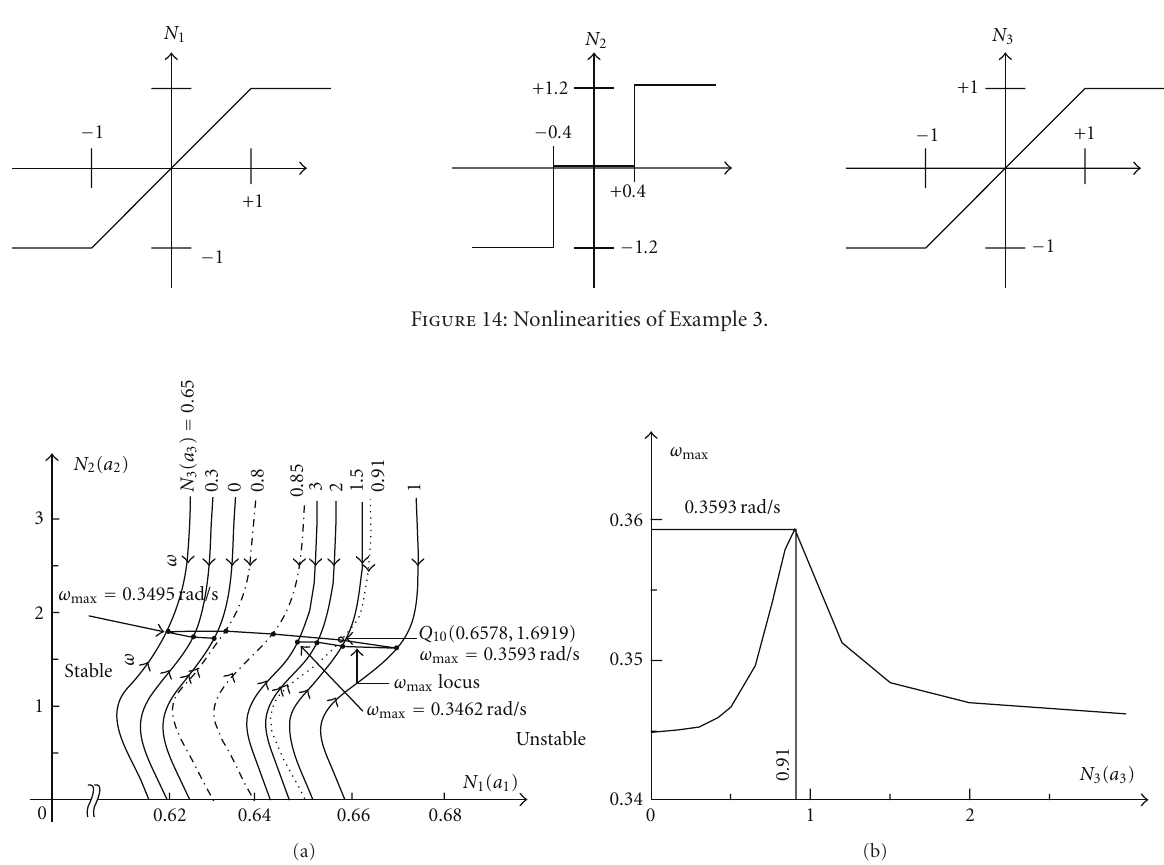
Figure 15: (a) Root loci analyses of limit cycles of Example 3. (b) ω max versus N 3 ( a 3 ) of Example 3.